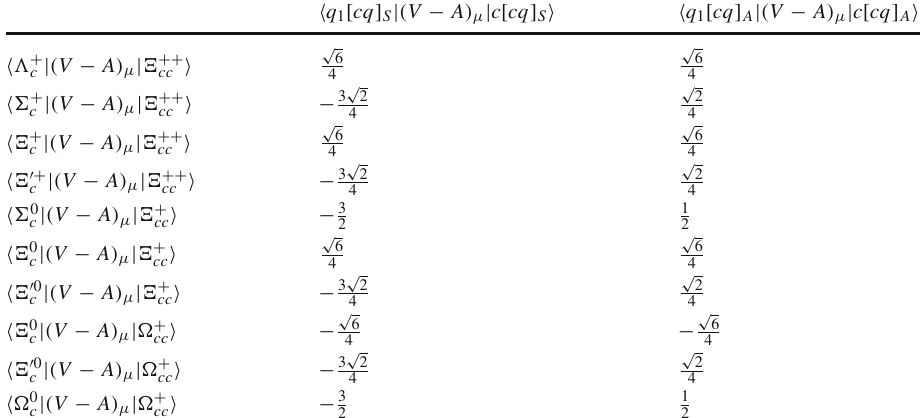
Table 4 Same as Table 3 but for the doubly bottom baryon